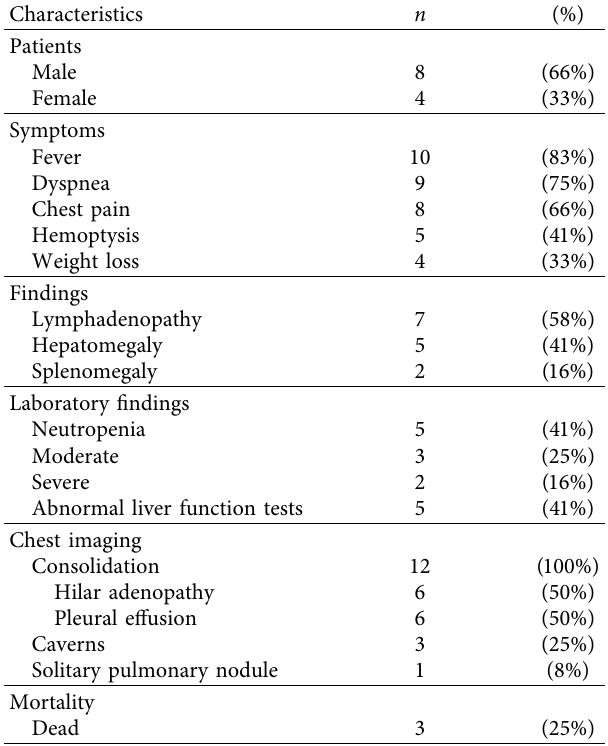
Table 3: Characteristics presented in immunocompetent patients with pulmonary